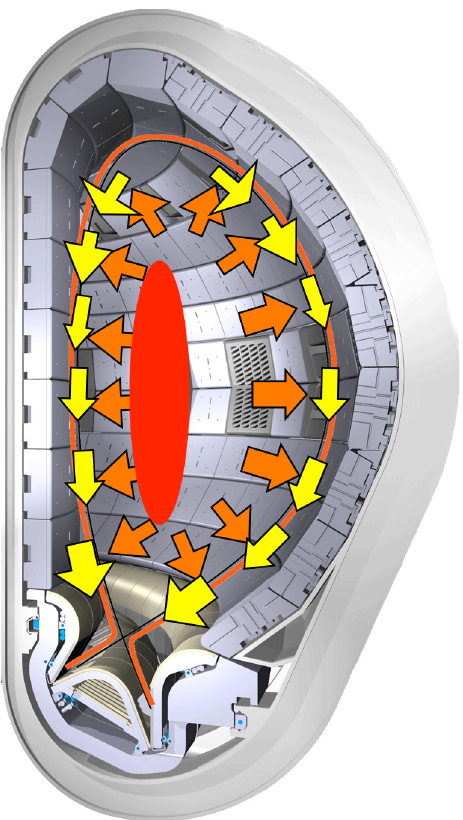
Fig. 3. – Divertor geometry. The orange line is the magnetic